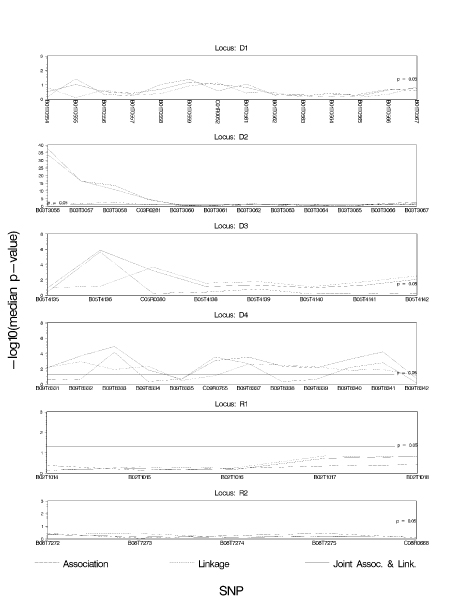
Association, linkage, and joint tests of association and linkage. Negative log10 of the median p-values are presented for analyses of the first 10 replicate simulations from the GAW14 data. Main effects of association, linkage, and joint linkage and association are shown for six chromosomal regions, four related to the KPD phenotype, D1–D4, and two regions, R1 and R2, that are in LD but are not related to KPD.